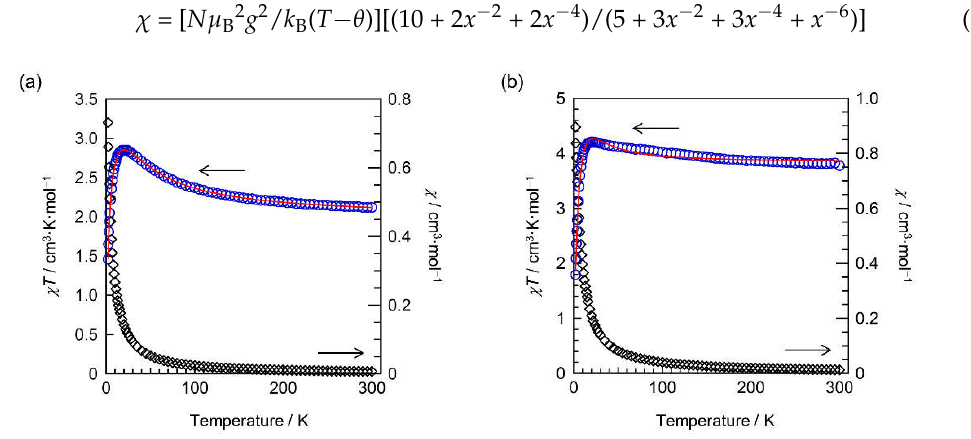
Figure 3. Temperature-dependent χ and χ T at 10 kOe of ( a ) [Ni II (hfac) 2 (PyBTM) 2 ] and ( b ) [Co II (hfac) 2 (PyBTM) 2 ]. Red lines indicate fitting curves. The fitting afforded J Ni-R / k B , g , and θ values of 21.8 K, 2.13, and − 2.63 K, respectively. The positive J Ni-R / k B value confirms an efficient FM PyBTM–Ni II